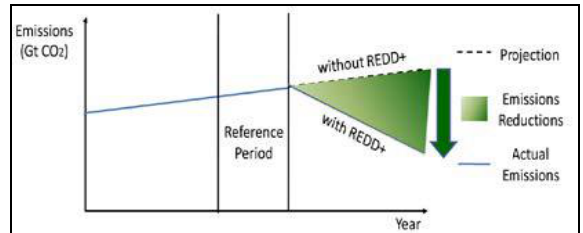
Figure 7. REDD+ potential for reducing GHG emissions (Note: Green shaded area is reduced emissions from REDD+ actions) [28] About